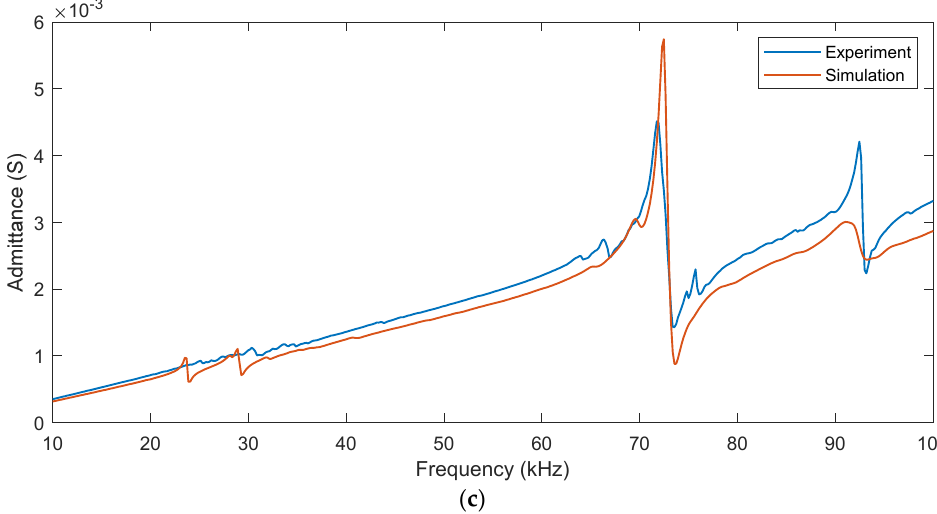
Figure 5. Comparison of impedance responses between the simulation and the experiment. ( a ) Real impedance signatures; ( b ) Imaginary impedance signatures; ( c ) Admittance signatures. Table 3. The frequency of the impedance peaks.